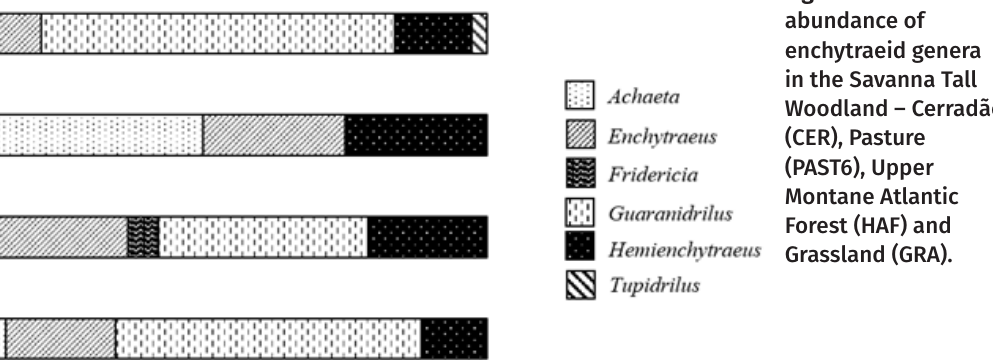
Figure 3. Relative abundance of enchytraeid